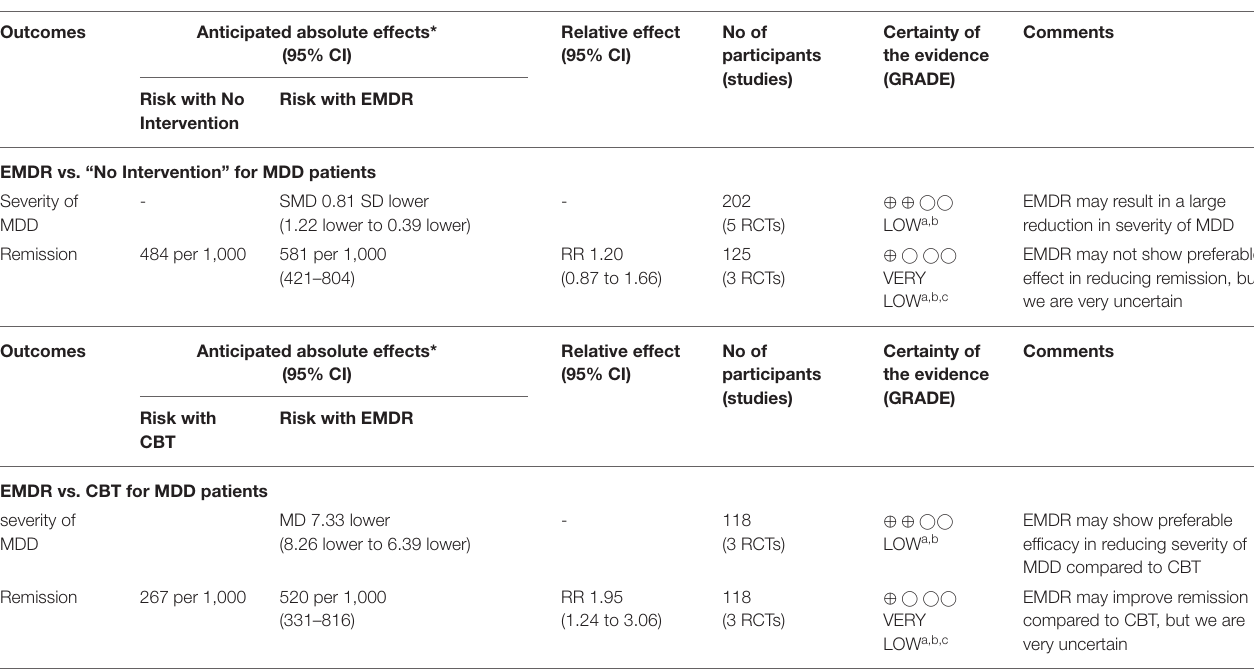
TABLE 2 | Summary of findings tables for EMDR vs. “No Intervention” and EMDR vs.